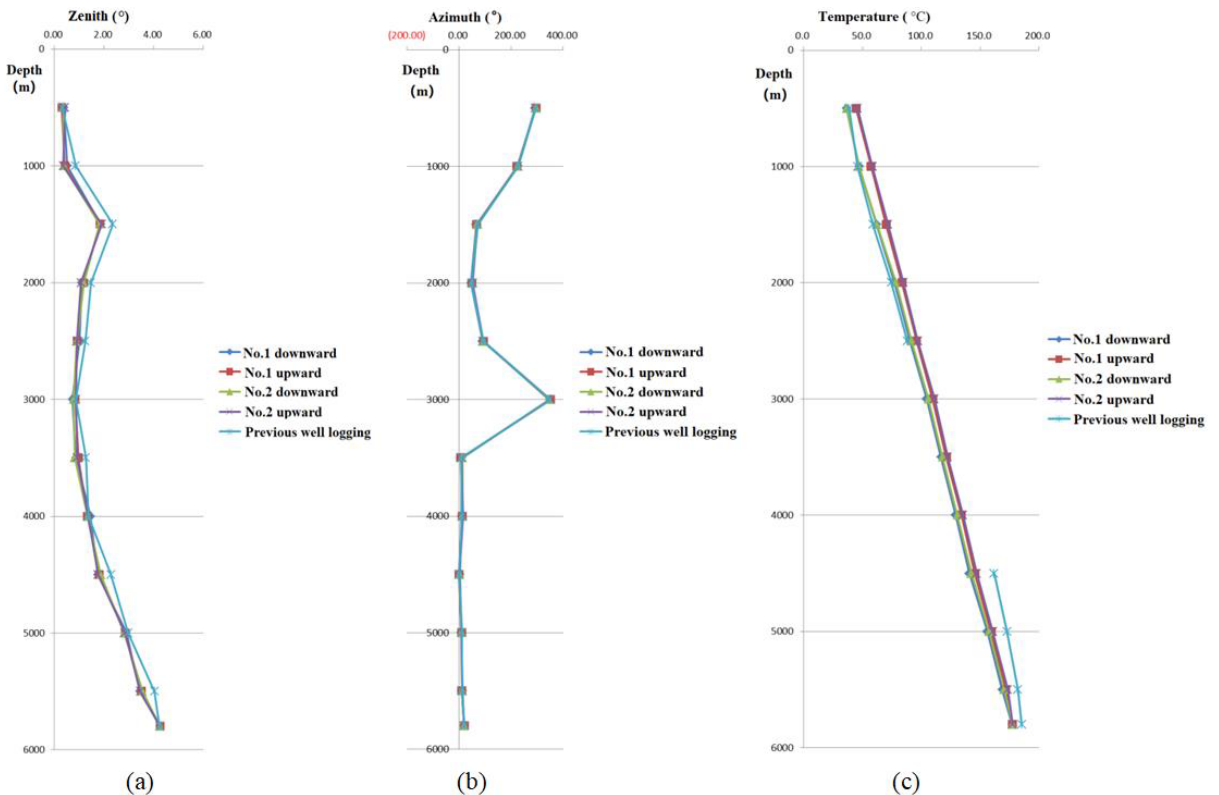
Figure 23. (a) Curve of measured zenith against borehole depth; (b) curve of measured azimuth against borehole depth; (c) curve of measured temperature against borehole depth. Table 10. Measured zenith angle of the Xingreguan-2 well, Beijing.